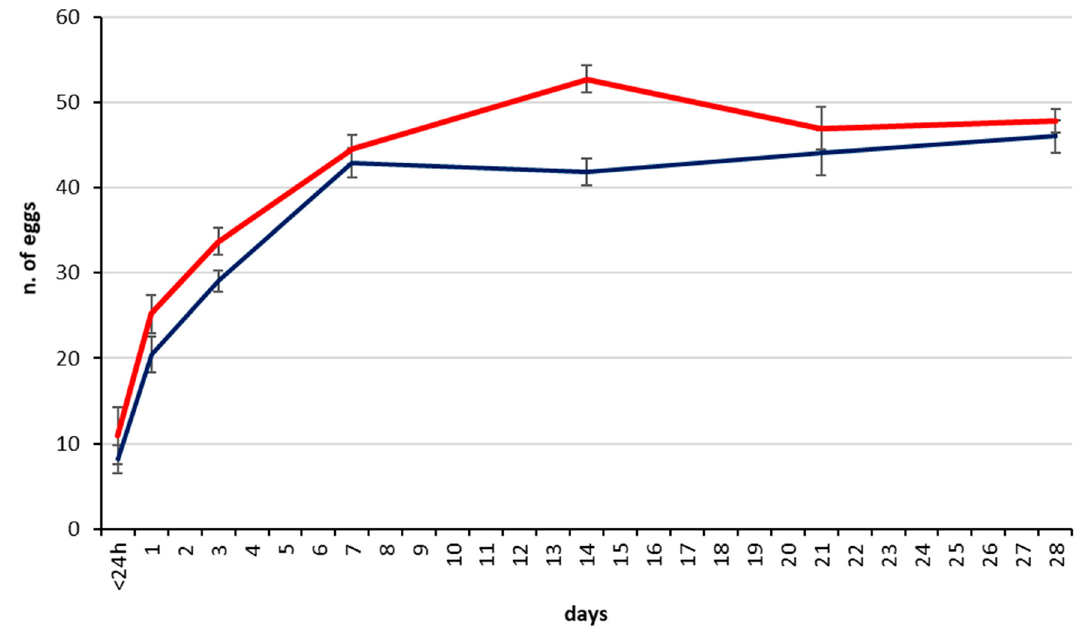
Figure 5. Trissolcus japonicus (blue line) and Trissolcus mitsukurii (red line) CREA colonies: total number of mature eggs in the ovary at different time intervals in females with no oviposition opportunity (bars indicate S.E.).